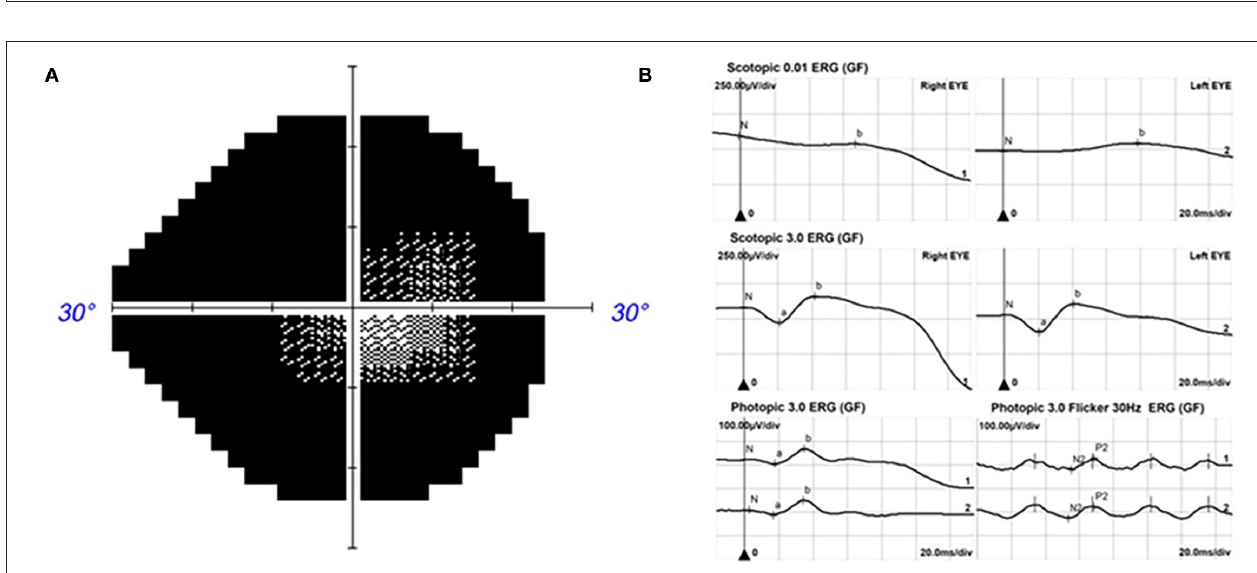
FIGURE 2 | showed diffuse macular thickening, splitting of the inner retinal layers with discrete bridging elements at the parafovea, and the outer retinal thickness was decreased and pointed by white arrows in (C,D) , the reduced retinal thickness and the absent ellipsoid band were more apparent in the nasal retina around the optic disc indicating atrophy of the outer layer of the retina (E) .